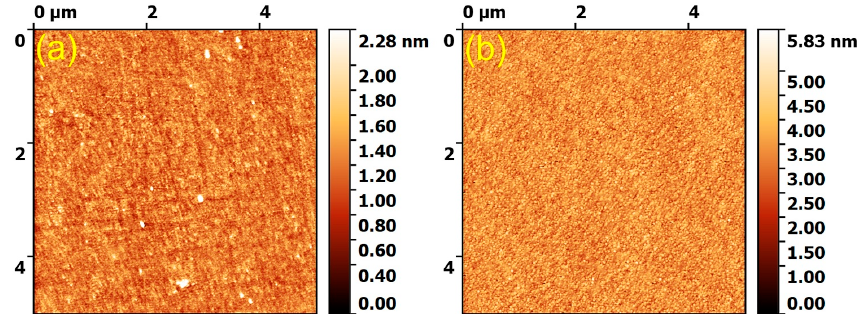
Figure 1. 2D atomic force microscopy (AFM) images recorded on 5 × 5 µm 2 surface areas of the ( a ) FastOs ® BG- and ( b ) Cu&Ga-FastOs ® BG-derived films.